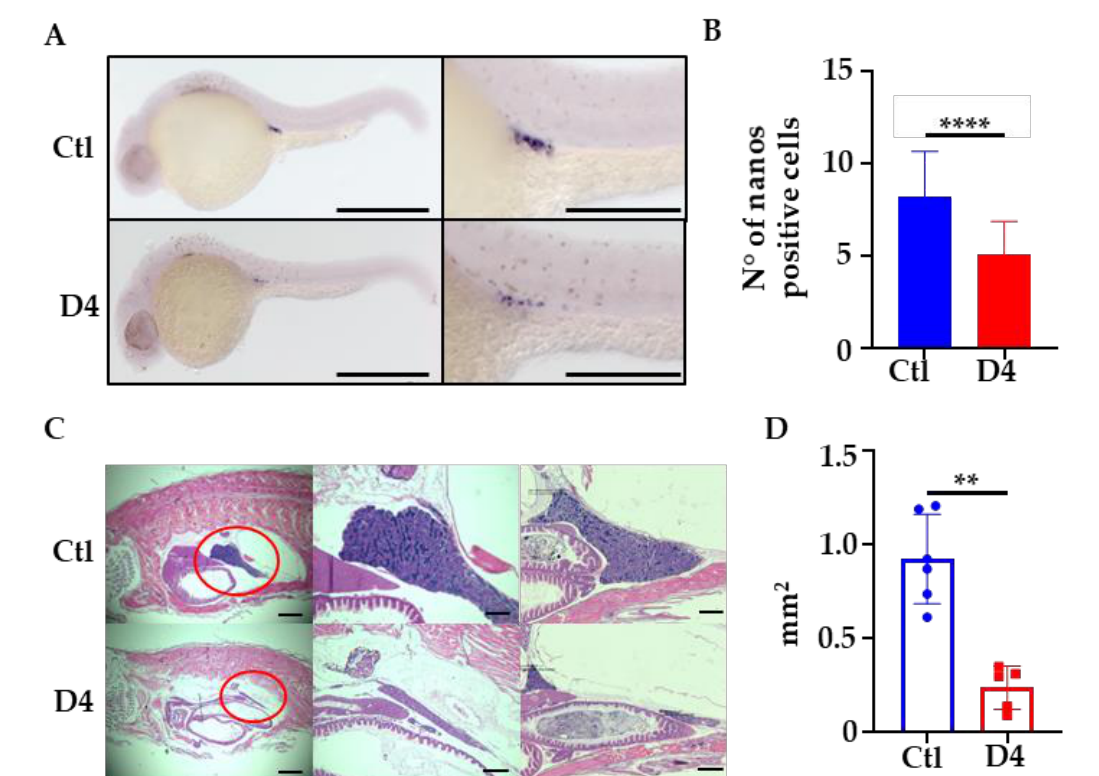
Figure 6. Primordial germ line and testis evaluation. ( A ) WISH for nanos3 in 24 hpf embryos. Size bar = 500 µm and 200 µm. ( B ) Quantification of nanos3 positive cells in control (Ctl) and D4 embryos (Ctl mean = 8.18 N = 83; D4 mean = 5.07 N = 85, **** p < 0.0001, Student’s t -test). ( C ) Representative histological sagittal sections of 1-year-old fish, stained with hematoxylin-eosin. Red circle indicates the testis. N = 5 for each group. Magnification 10× and 40×. Size bar = 2000 µm and 500 µm ( D ) Quantification of testis area performed on histological sections; Ctl mean = 0.92 mm 2 ; D4 mean = 0.24 mm 2 ** p < 0.01, Mann – Whitney U test.